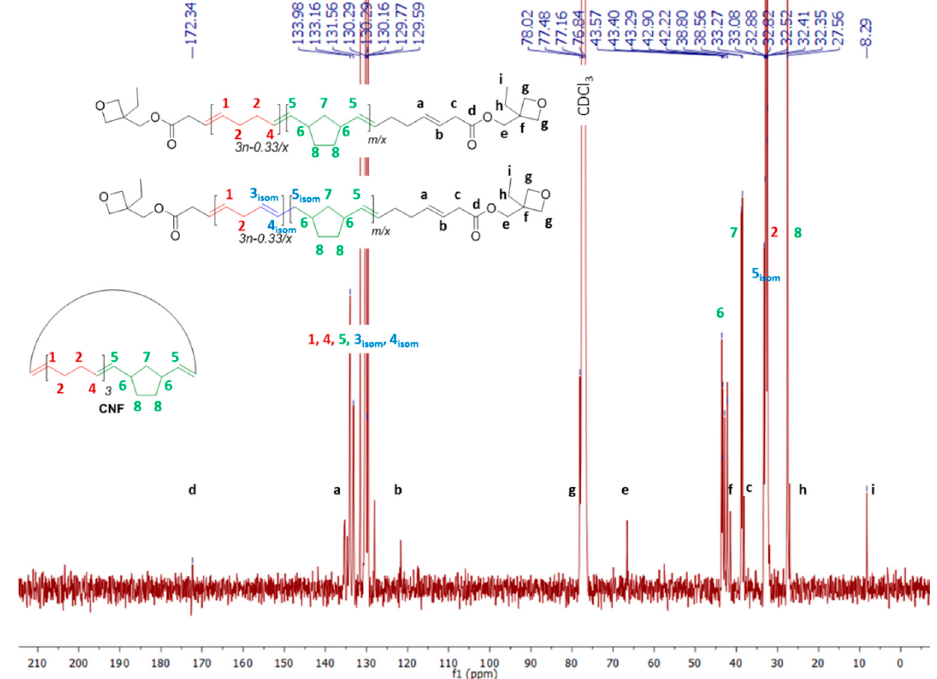
Figure 4. 13 C{ 1 H} NMR spectrum (125 MHz, CDCl 3 , 25 °C) of an α , ω -oxetane telechelic P(NB- co -CDT) copolymer sample that was prepared by ROMP/CM of an equimolar mixture of NB/CDT in the presence of G2 /CTA 3 in CH 2 Cl 2 (Table 3, entry 8).